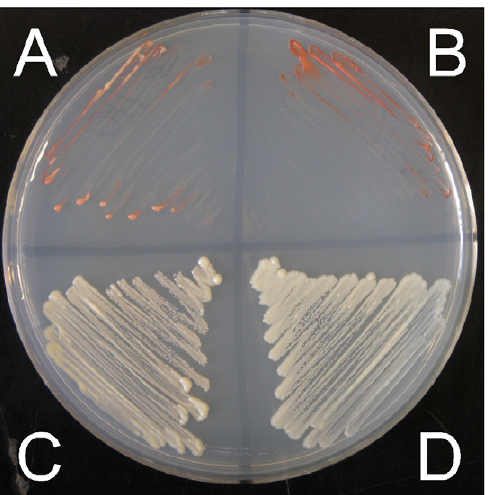
Figure 3. ADE2 expression requires native transcription factor binding sites, and is repressed by the M26 motif in sko1 + . Growth of strains on NBA dropout medium lacking adenine after two days at 30 u C. A) Wsc110; ade2-1021 ( M26 no 5 9 -stop), B) Wsc166; ade2- 1047 (Bas1/Reb1 KOs), C) Wsc202; ade2-1021 ( M26 -no 5 9 -stop sko1 D ), D) Wsc24; ade2 + .